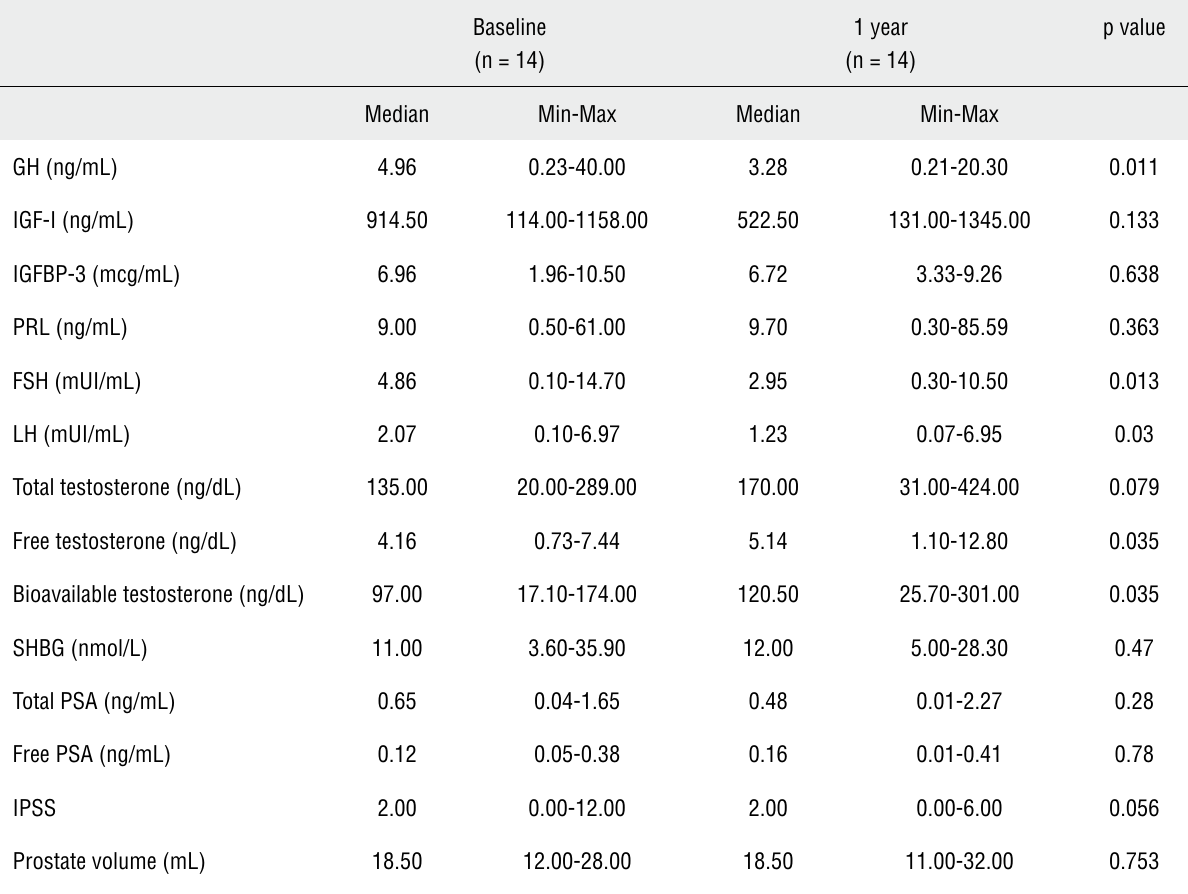
Table 3 - Characteristics of acromegalic patients at baseline and after one year of treatment (< 40 years-old).